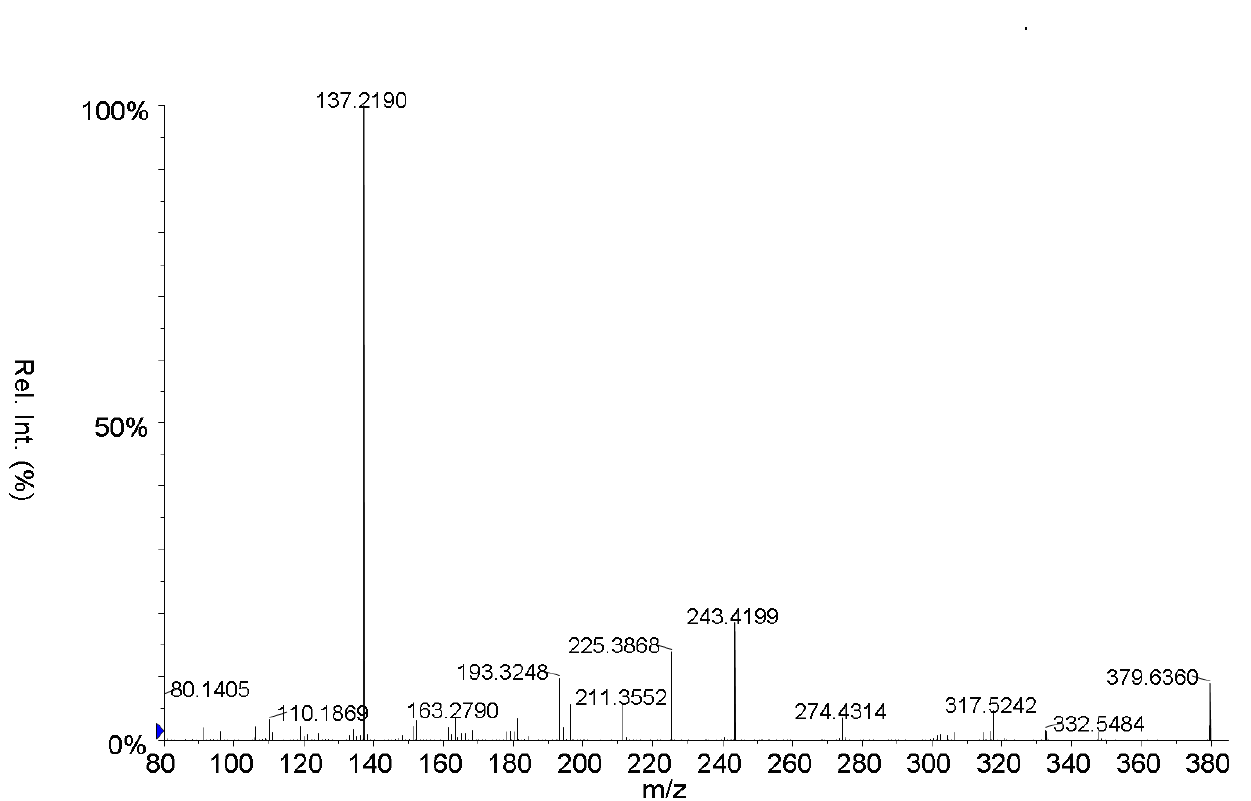
Figure 1. MS/MS spectrum of the protonated molecular ion of O-methoxy-pentanedialdoxime-HTyr.